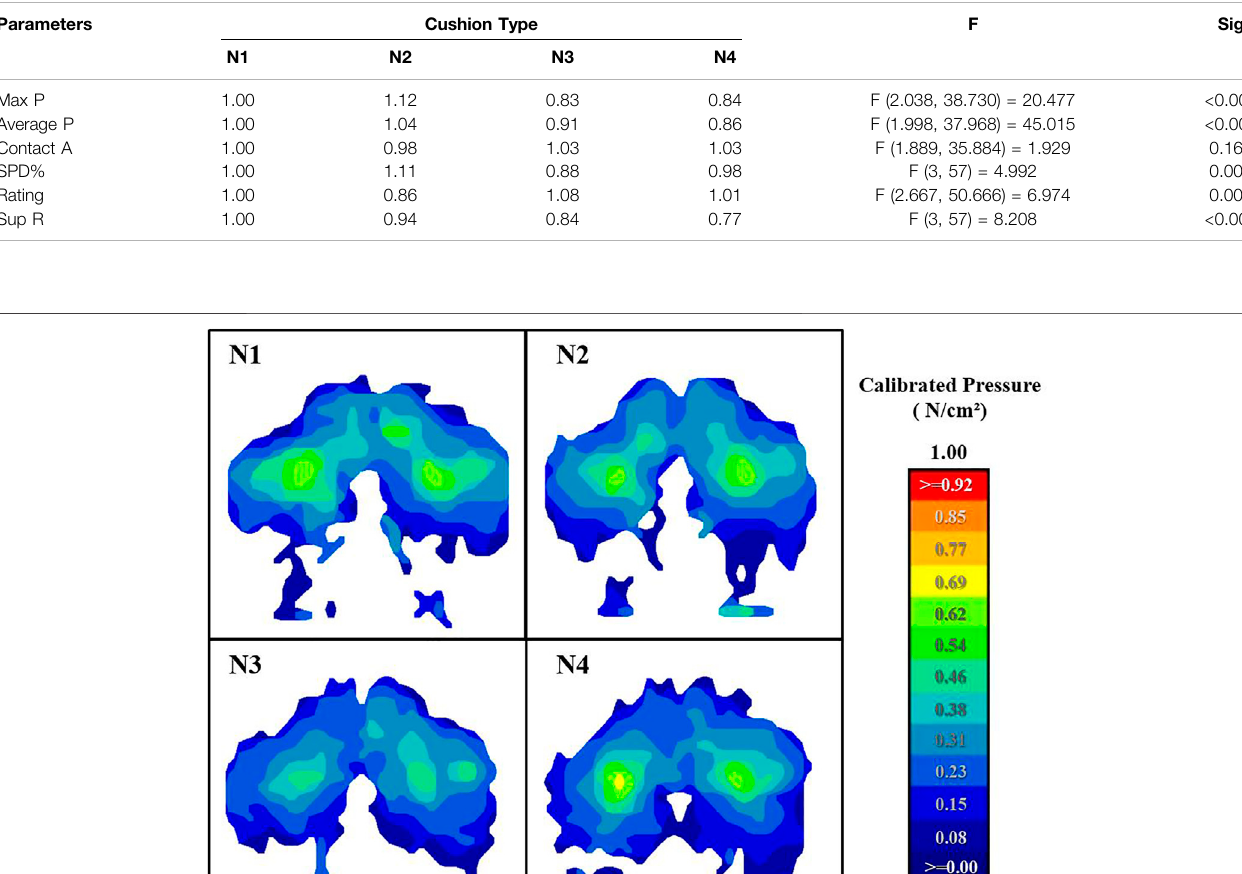
TABLE 3 | The comparison of the mean values between the four cushions, using N1 as the standard, and the signi fi cance of each parameter to different cushions ( n (cid:1) 20).